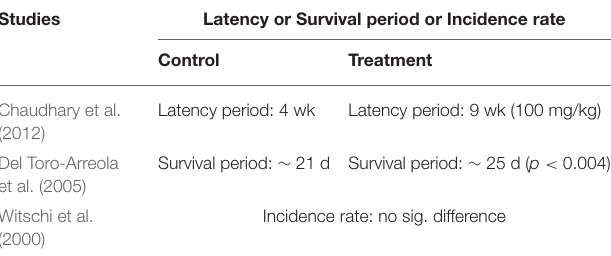
TABLE 2 | Effects of limonene intervention on latency period and tumor incidence.